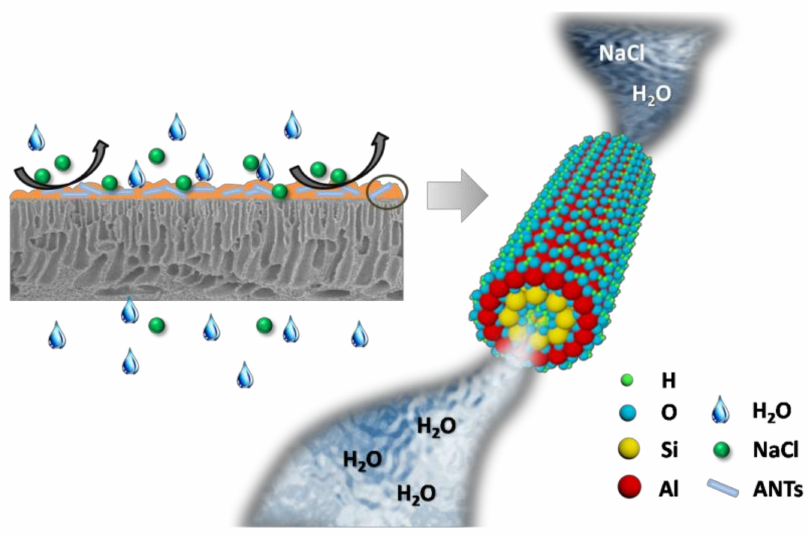
Figure 8. Schematic illustration for TFN membranes with ANTs embedded PA rejection layer and water transport through the inner pores of